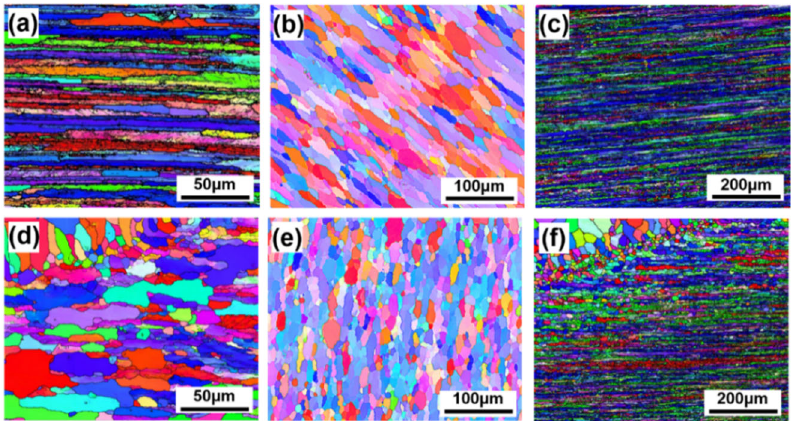
Figure 7. Electron backscatter diffraction detector (EBSD) images of aluminum alloy welding joints: 5083: ( a ) base metal (BM); ( d ) HAZ; 6005A: ( b ) BM; ( e ) HAZ; 7N01: ( c ) BM; ( f ) HAZ.